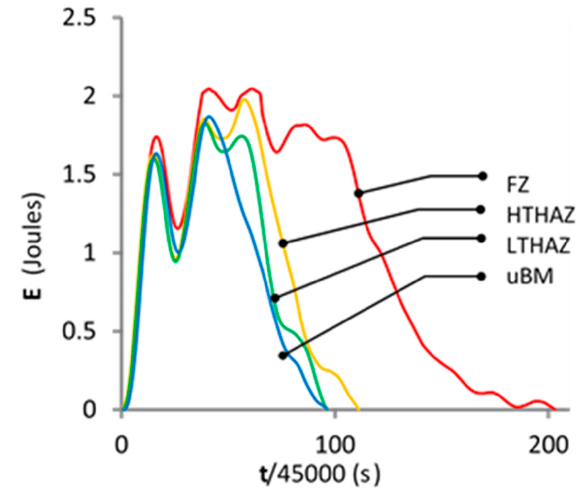
Figure 5. Energy versus unit of time chart for Charpy Impact tests of AISI 304 welding.